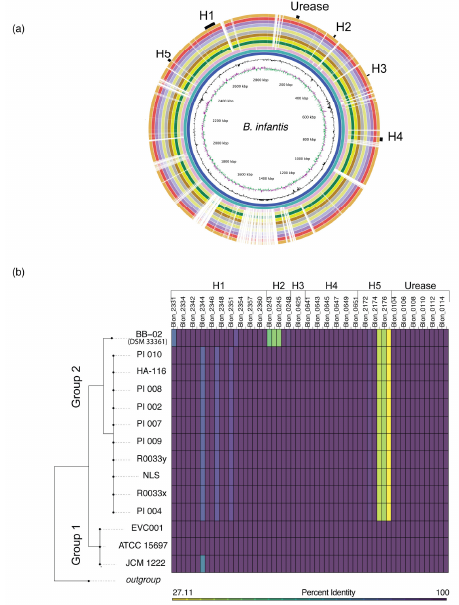
Figure 1. Genomic comparison, phylogenetic relatedness, and human milk oligosacharide (HMO) gene distribution of B. infantis strains compared to the type strain, B. infantis ATCC 15797. ( a ) Circular map of 13 B. infantis strains in comparison to the type strain B. infantis ATCC 15697. The innermost rings represent the% G + C (black) and the GC skew (green / purple). HMO-utilization clusters, numbered H1 to H5 and the urease cluster are represented by black boxes next to the outermost ring. The remaining circles display BLASTn searches against the genome of B. infantis ATCC 15697. Genomes circles are ordered sequentially based on decreasing average nucleotide identity (ANI) scores (Table S1) beginning with the genome of JCM 1222 (most inner blue circle) and followed by EVC001, BB-02 (DSM 33361), PI_004, PI_007, PI_009, PI_010, NLS, R0033x, PI_002, HA-116, R0033y, PI_008. Homology regions are colored from lightest to darkest shade, respectively. Regions with less than 70% identity appear as blank spaces in each ring. ( b ) Heat map displaying MLST phylogenetic relatedness and percent sequence identity (determined by tBLASTn) of HMO utilization genes compared to the genome of B. infantis ATCC 15697. The color of each tile of the heat map indicates the percent homology as indicated by the key. Tiles representing the genes of each cluster are arranged sequentially but, for space constrains, only every other Blon_ locus tag is